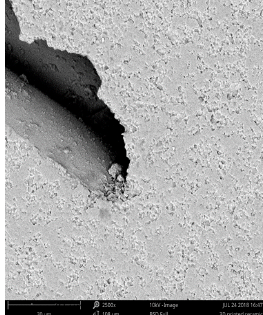
Figure 10. SEM image of a generated cavity.